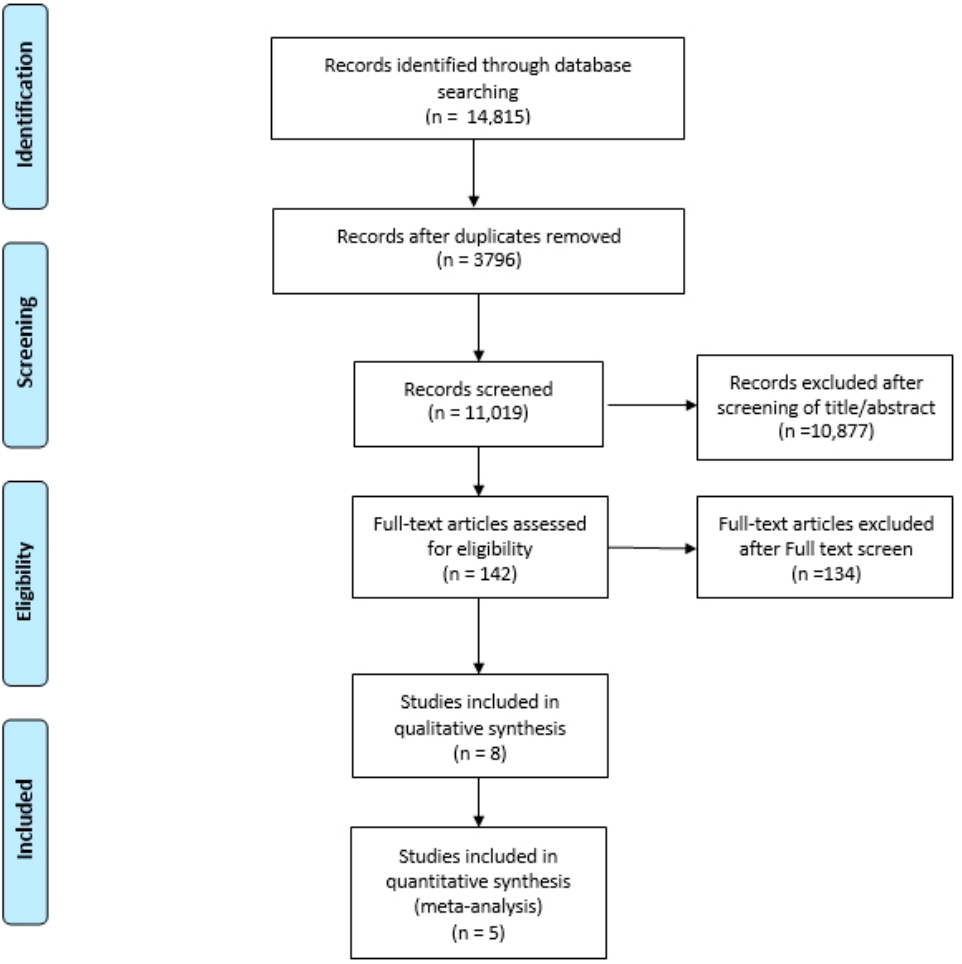
Figure 1. PRISMA flow diagram for the systematic review. Table 1. Characteristics of the included